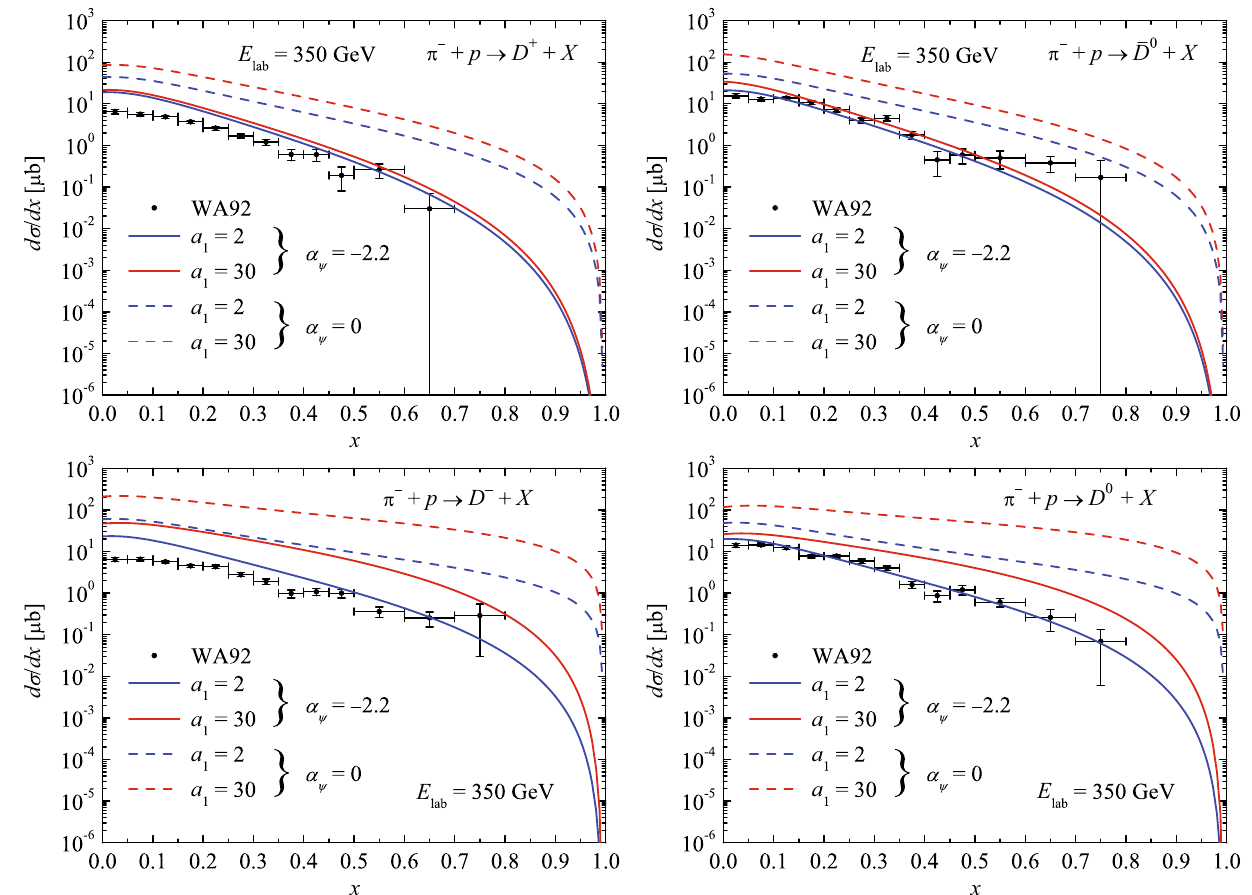
Fig. 6 Differential cross sections of each type of D mesons ( D + , D − , D 0 , ¯ D 0 ) production in π p collisions at E lab = 350 GeV. QGSM calculations for α ψ ( 0 ) = − 2 . 2 (solid lines) and α ψ ( 0 ) = 0 (dash). Points are experimental data from [47]